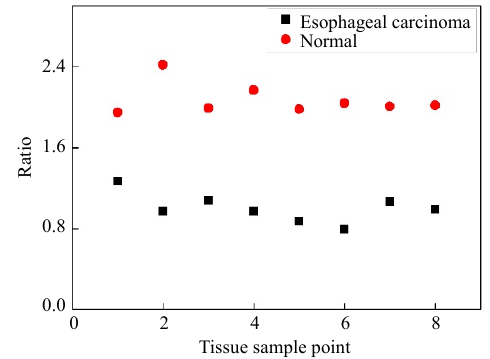
Fig. 6 Ratio distribution diagram of the integral energy of two Raman spectrum bands of the normal and carcinoma